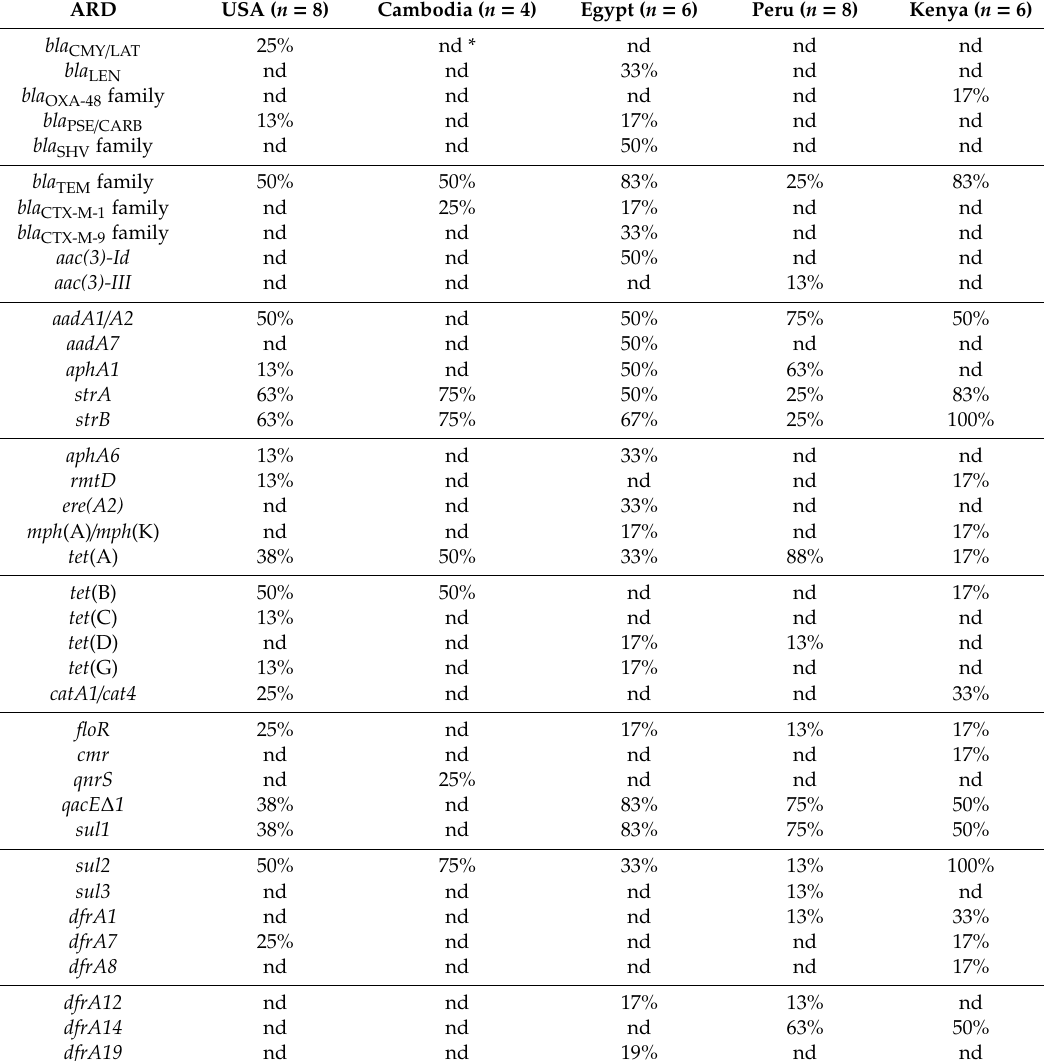
Table 5. ARDs detected in Salmonella spp., by geographic location (percent of isolates